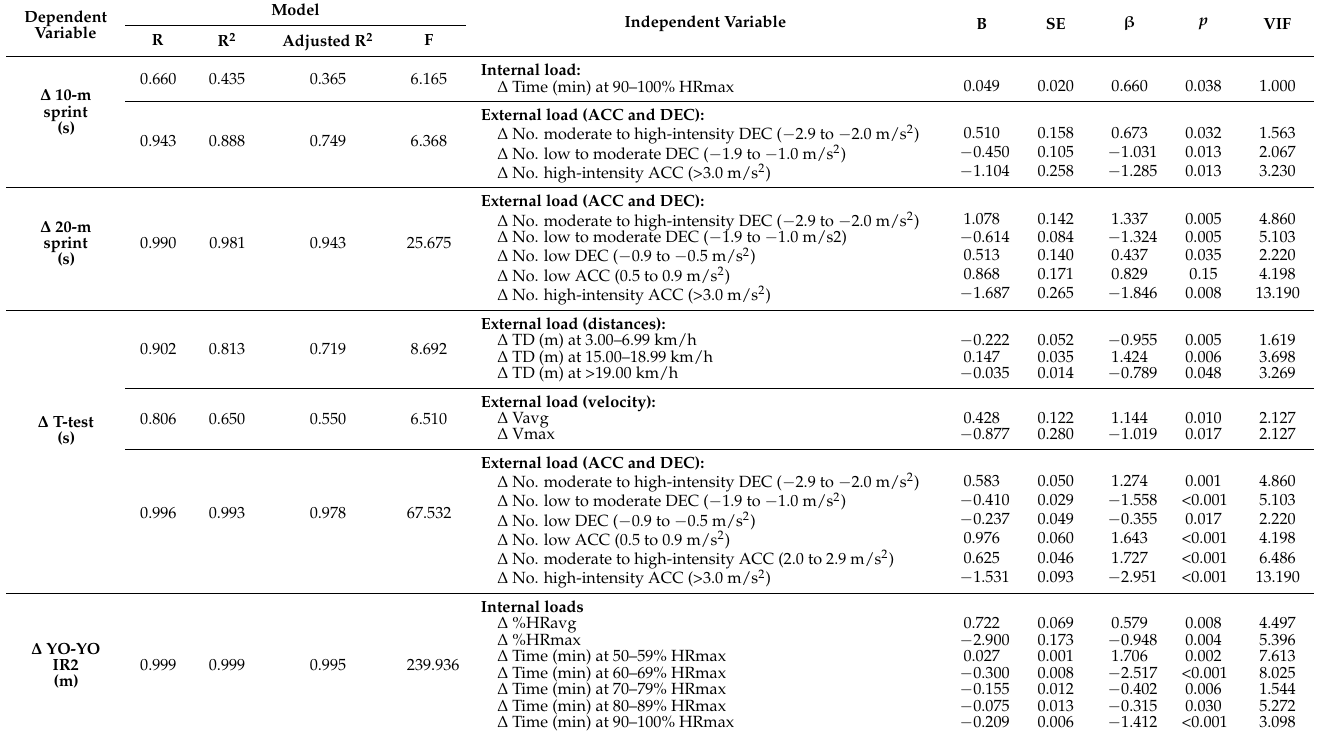
Table 4. Values of multiple linear regression with backward stepwise elimination explaining the contribution of internal and external loads to the percentage change ( ∆ ) of fatigue measurements. Only statistically significant models are